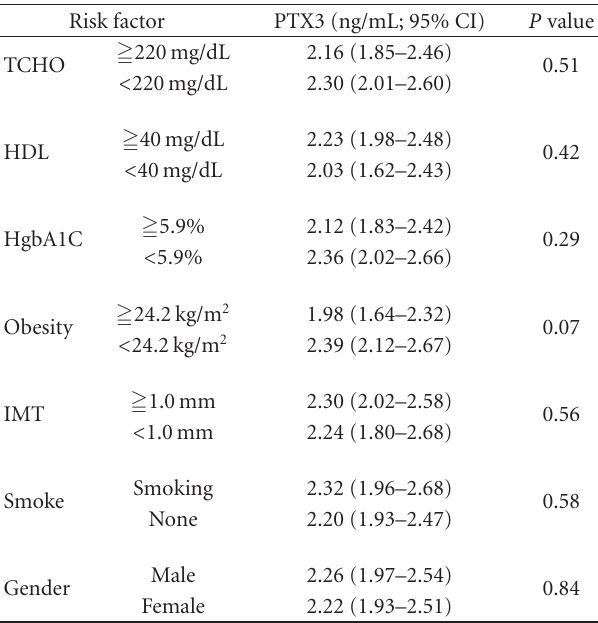
Table 1: Geometric mean PTX3 plasma levels by CHD risk factors